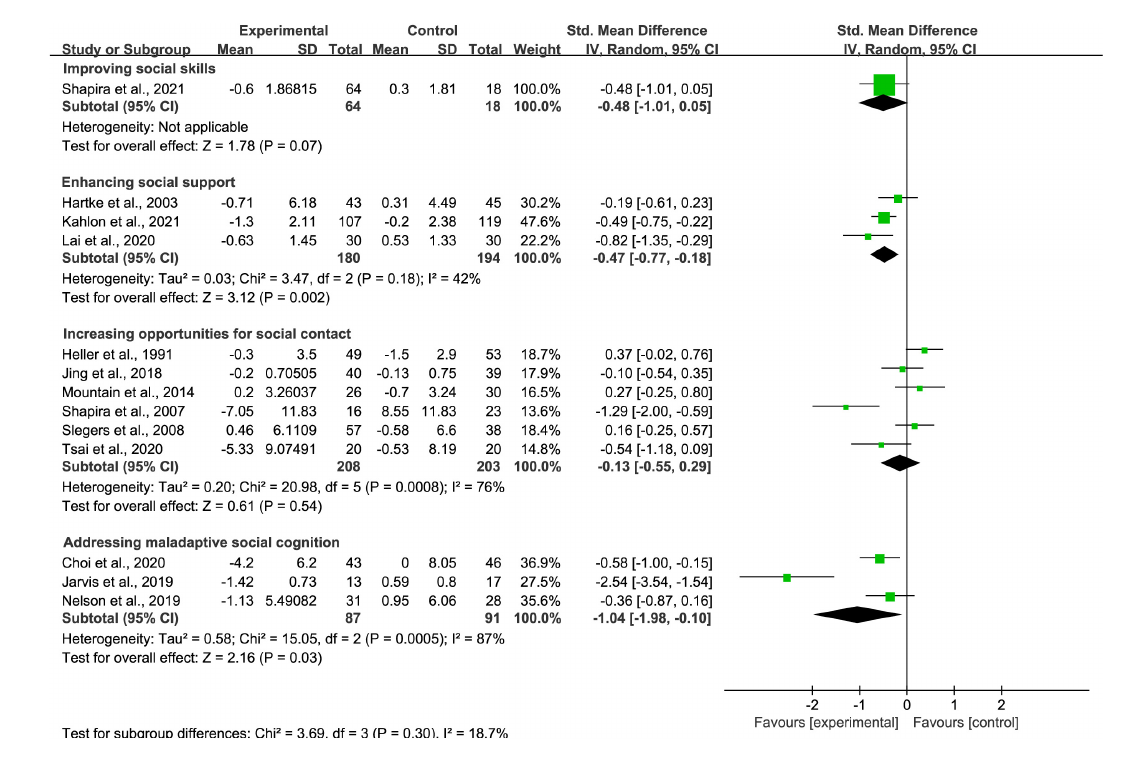
FIGURE5 Subgroup analysis: comparison of improving social skill interventions, enhancing social support interventions, increasing opportunities for social contact interventions, or addressing maladaptive social cognition interventions and all controls on the basis of loneliness